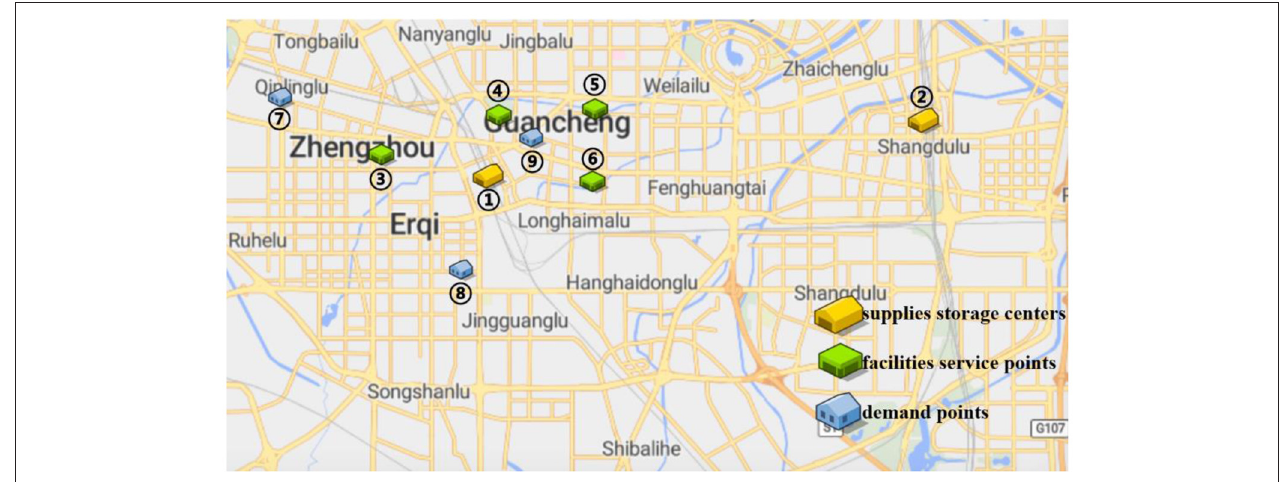
FIGURE 1 | Locations of three types of mobile emergency stations in Zhengzhou.